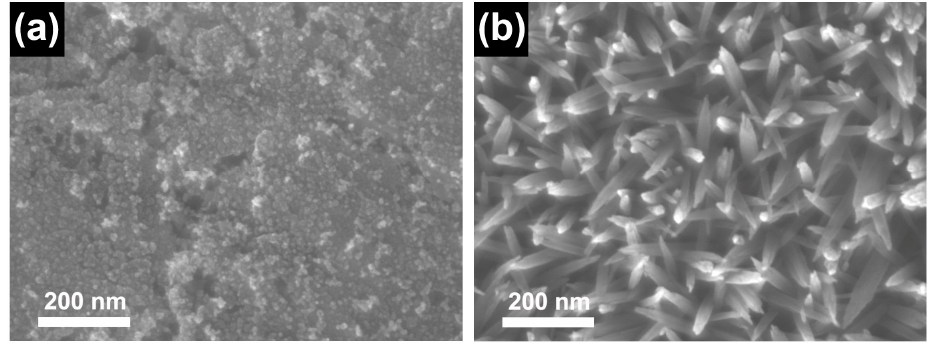
Figure 5. SEM images of Zn foil immersed in 0.1 M NaOH at 25 °C for 24 h. ( a ) Front surface. ( b ) Back surface.